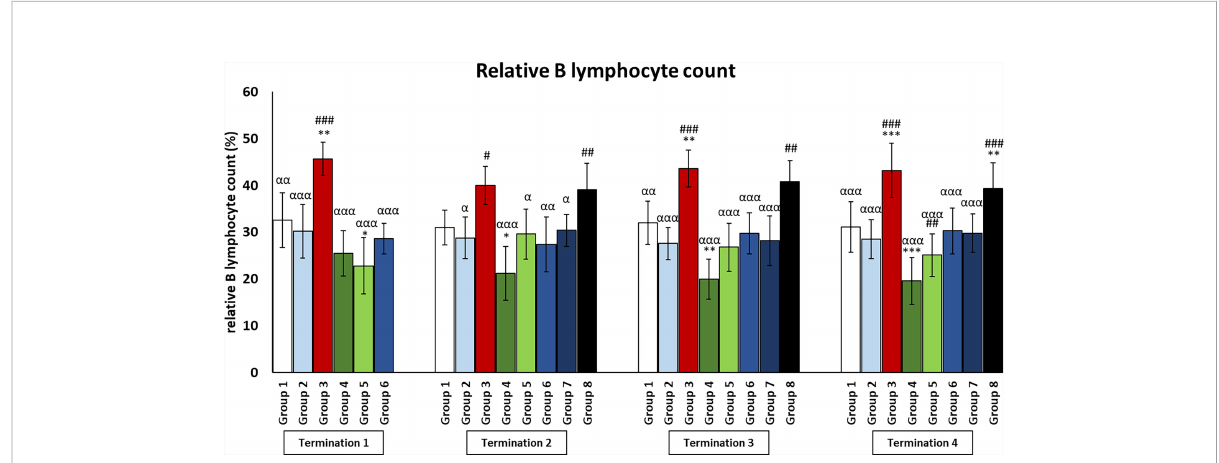
FIGURE 7 Changes in lymphocyte B counts in the blood of chickens receiving phage therapy or antibiotic therapy after 6, 20, 28, and 34 days of experiments. Results are presented as mean values ± SD. Statistical analyses were performed by Kruskal – Wallis test and post-hoc Dunn test or ANOVA and post-hoc Tukey ’ s test. The signi fi cance of differences between controls and particular treated groups is observed and marked by the following: asterisks (*) vs. saline control; (#) vs. phage control (group 2); (a) vs. infected control (group 3); (g) vs. termination 2. p < 0.001 (***, ###, aaa ), p < 0.01 (**, ##, aa ), and p < 0.05 (*, #, a